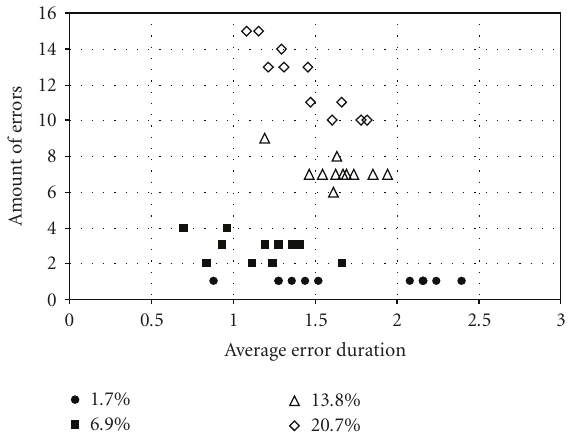
Figure 7: Video errors for MFER 1.7%, 6.9%, 13.8%, and 20.7% for the test performed in [5].